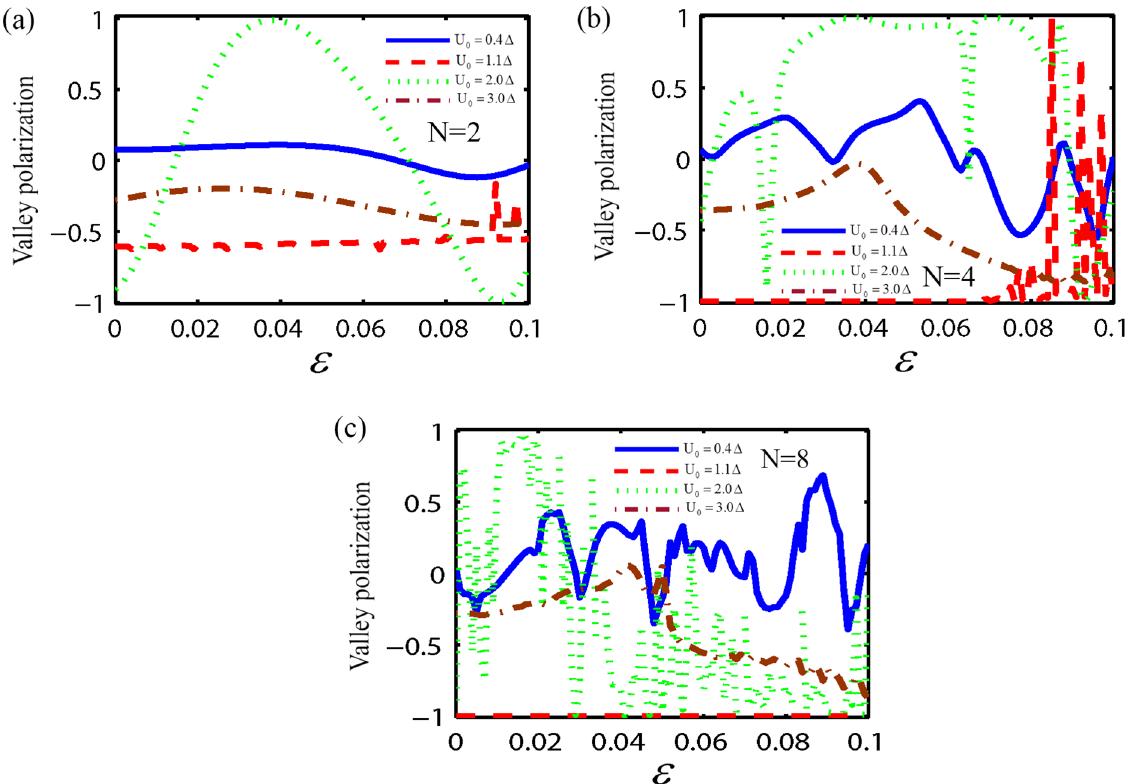
Figure 5. Dependence on the ε of the valley spin polarization with several values of the height of the electrostatic potential barrier, for fixed E = 1.5 (cid:31) , (cid:31) R = 50 meV, k F 0 b = 5 and for ( a ) two barrier, ( b ) four barriers, and ( c ) eight barriers